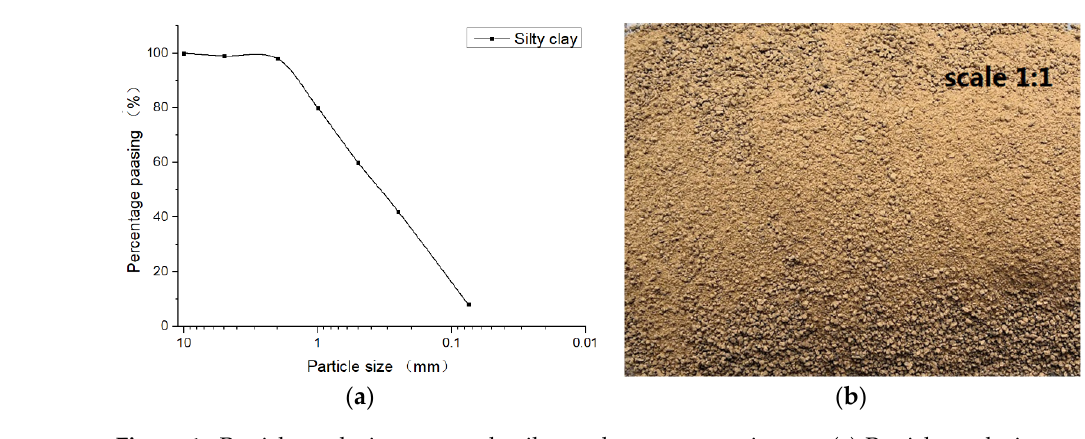
Figure 1. Particle analysis curve and soil sample appearance image. ( a ) Particle analysis curve; ( b ) Silty